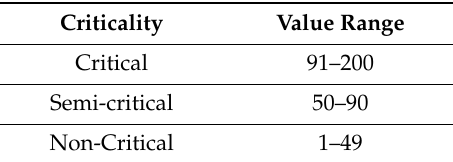
Table 5. Criticality limits.